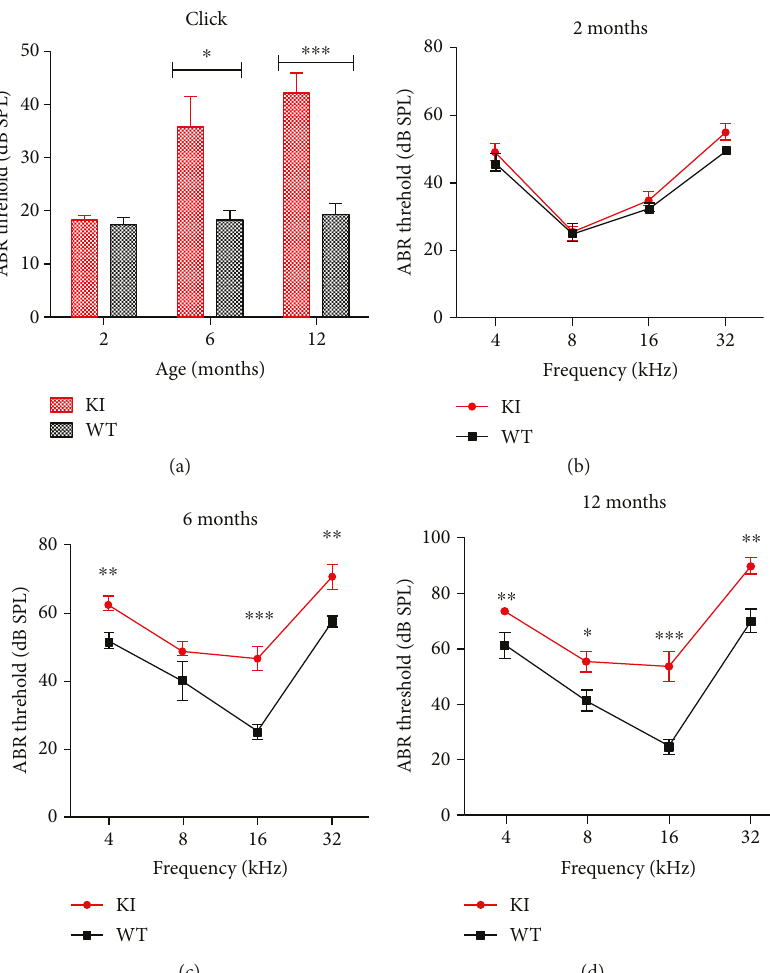
Figure 2: ABR analysis in Myo3a mutant mice (red) and wild-type mice (black) at two months, six months, and twelve months. (a) ABR measurements for broadband click. (b) Frequency-speci fi c pure tone stimulation of Myo3a KI/KI mice and wild-type mice at two months old (b), six months old (c), and twelve months old (d). In contrast to wild-type mice, Myo3a KI/KI mutant mice showed progressive hearing loss. Compared with WT threshold at the corresponding frequency as determined by Student ’ s t -test. ∗ P < 0 05 ; ∗∗ P < 0 01 ; ∗∗∗ P < 0 001 . Error bars indicate SEM. n > 5 for control and mutant mice for each